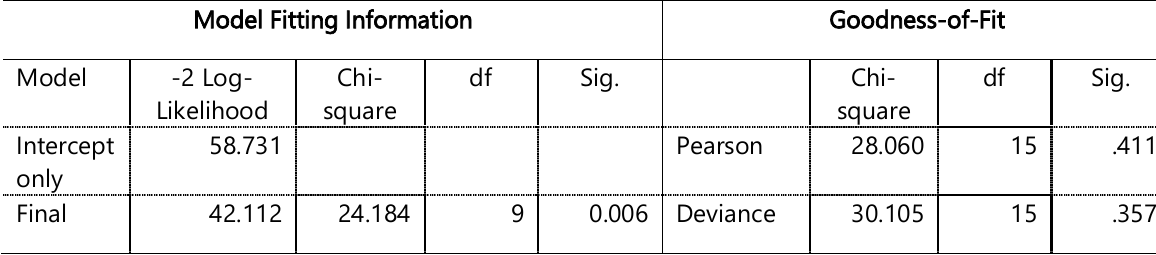
Table 3: Model Fit and Goodness-of-Fit Information (Source: Authors‟ calculation) Model Fitting